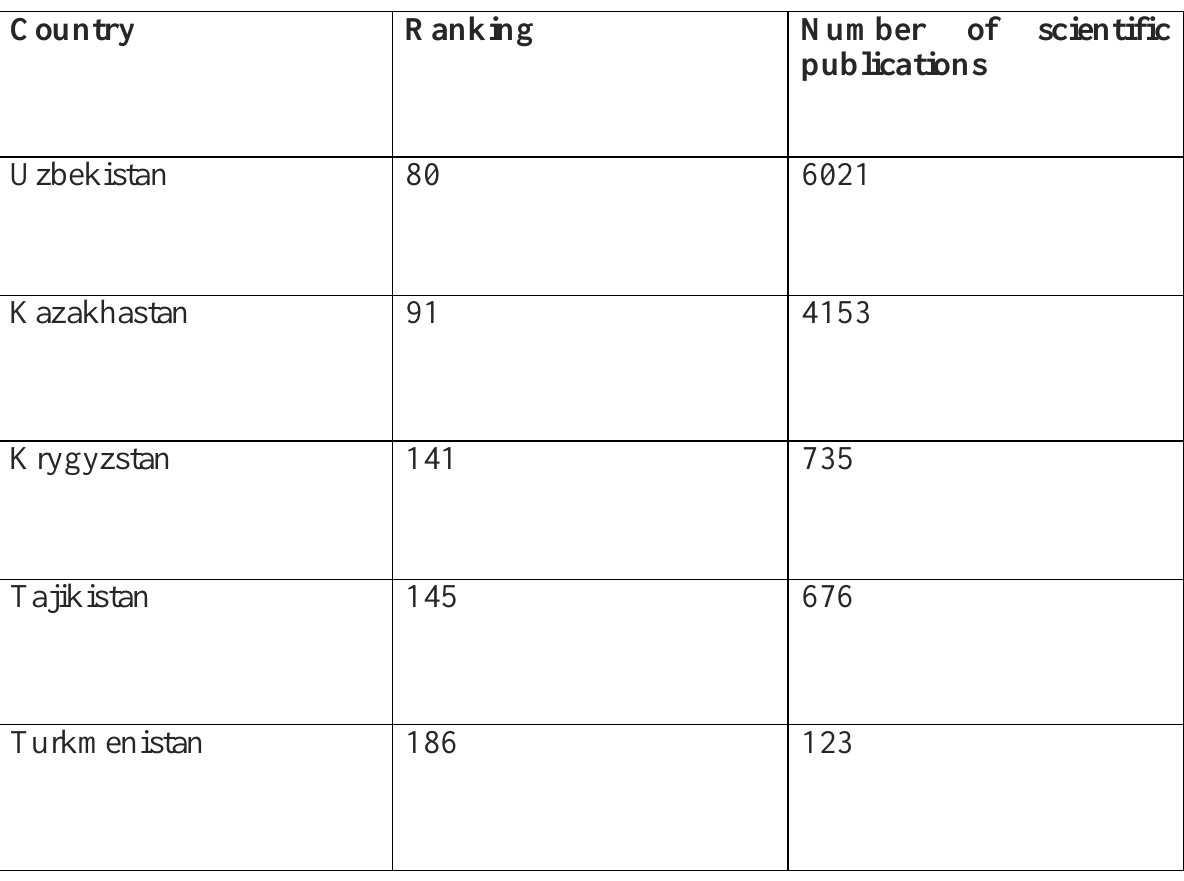
Table 1: The rate of publication for the Central Asian countries and their ranking worldwide.